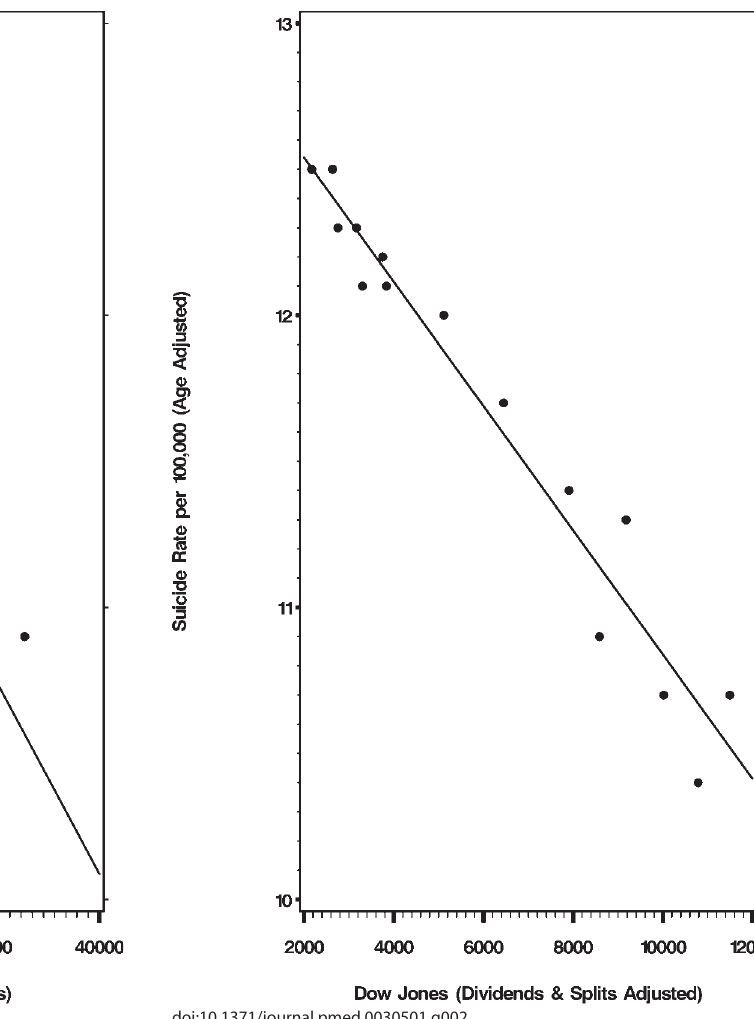
Figure 1. Correlation between Suicide Rates and Fluoxetine Prescriptions